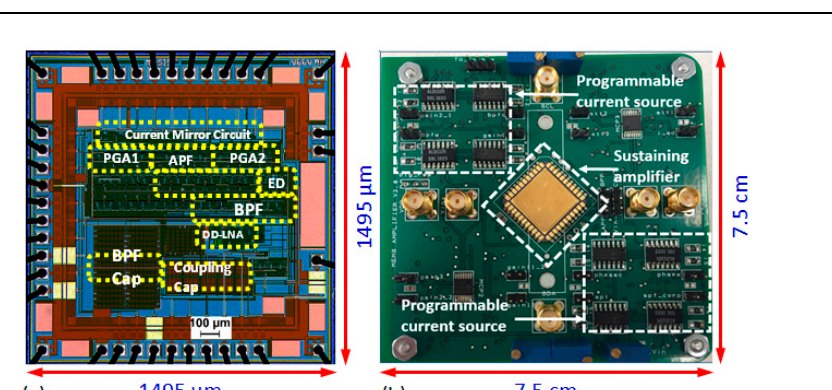
Figure 4. ( a ) Die micrograph of the CMOS sustaining amplifier; ( b ) Test board used for characterizing the amplifier and integrating with the MEMS resonator to build the